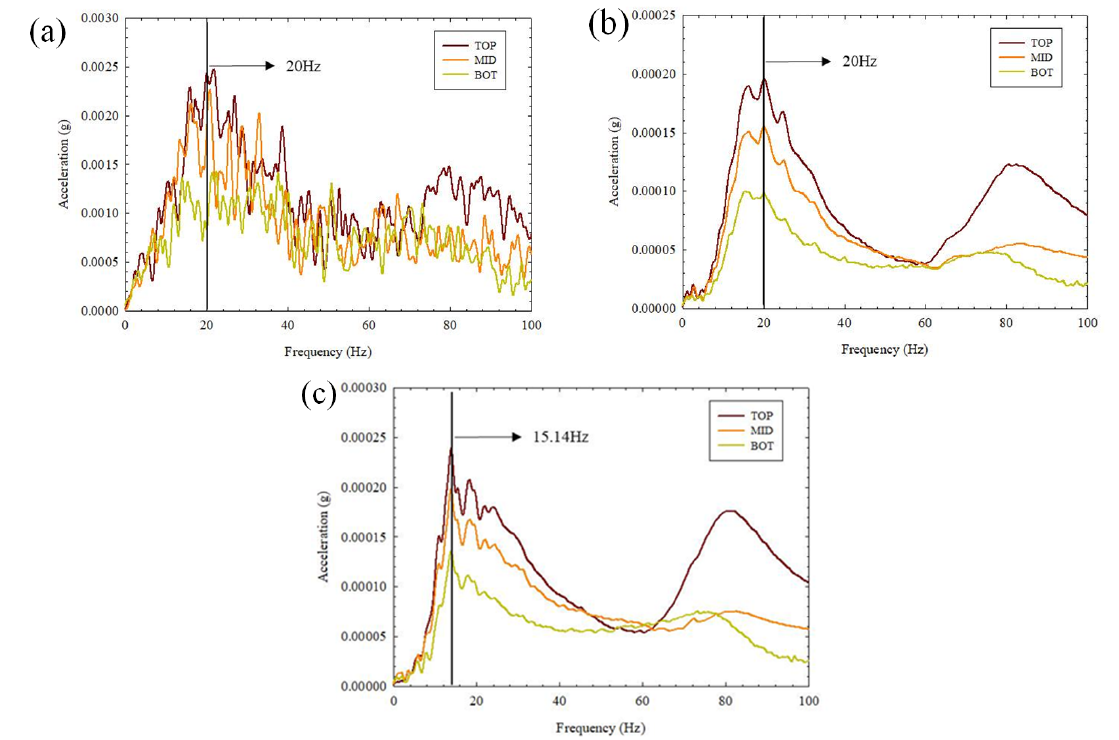
Figure 13. Second mode natural frequency for each field condition. ( a ) With a girder; ( b ) without a girder; and ( c ) 1 m deep scour on the ground adjacent to the pier.